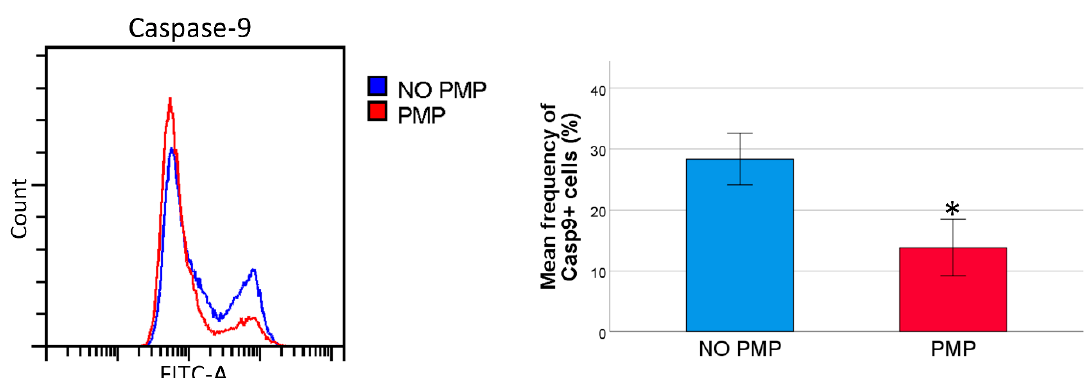
Figure 3. Caspase-9 activation in daunorubicin (DNR)-induced cell death. DNR-treated THP-1 cells were analyzed for caspase-9 activation ( n = 3). Caspase-9 positive cells were identified as the distinct second peak in the flow histogram. p values were calculated using the paired-sample t test. * p < 0.05.